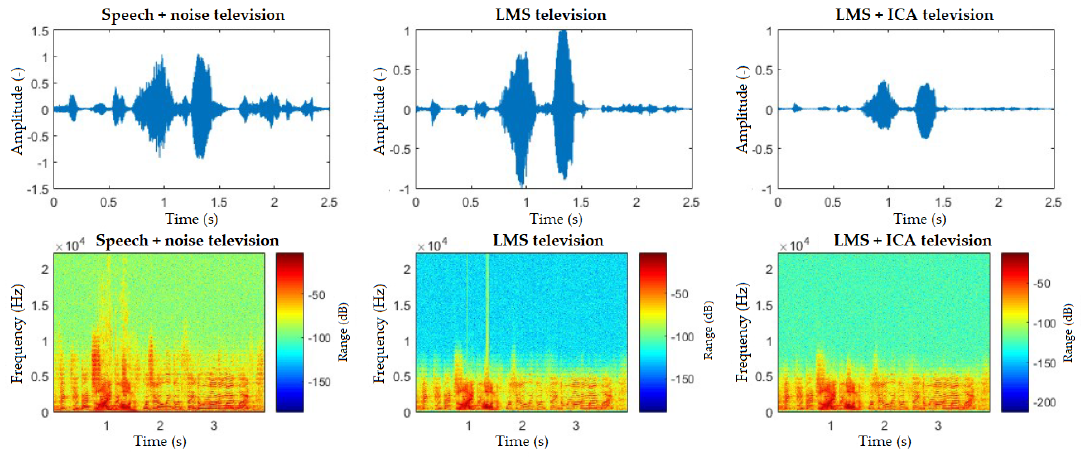
Figure 14. Comparison of spectrograms with closed windows, “light on” command, television